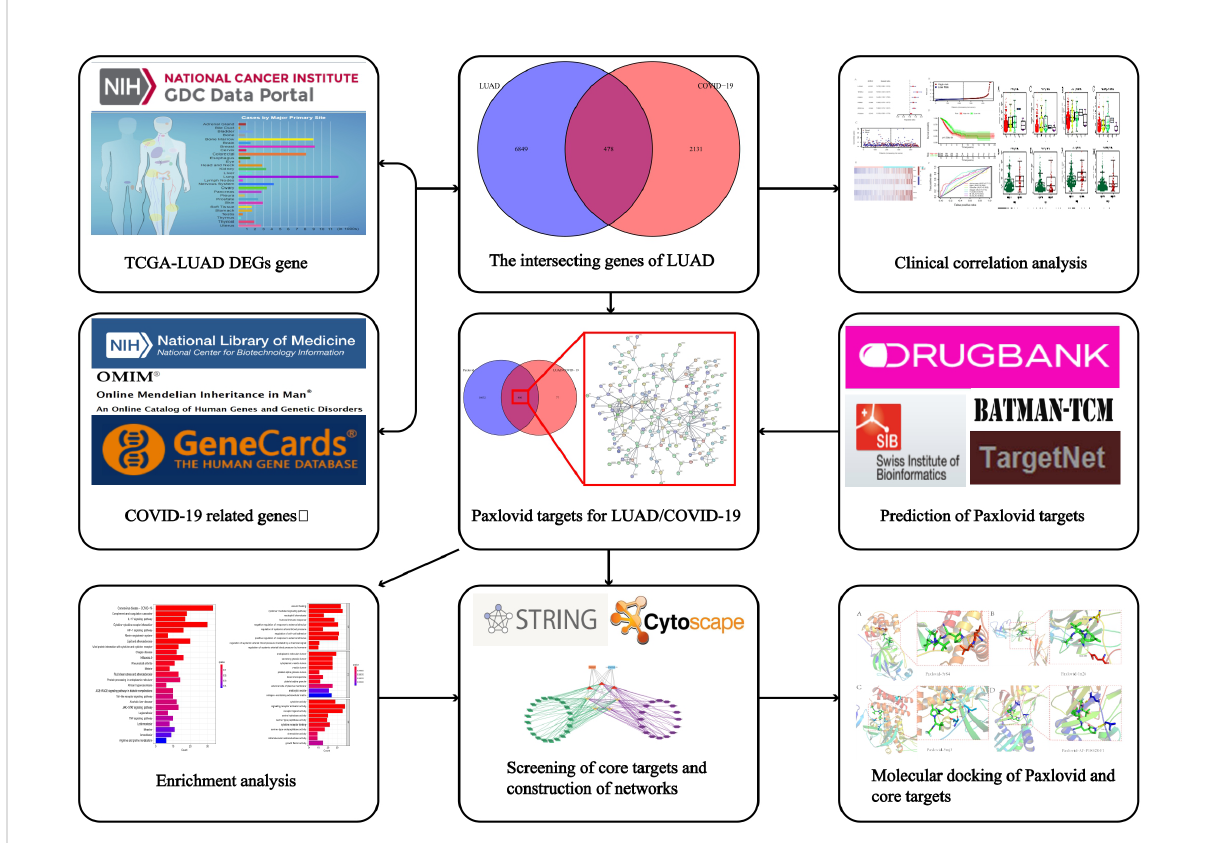
FIGURE 1 Work fl owof the study. The fi gureindicatesthe antiviral actionand mechanism ofPaxlovid against LUAD/COVID-19using the network pharmacology and computational bioinformaticsanalysis